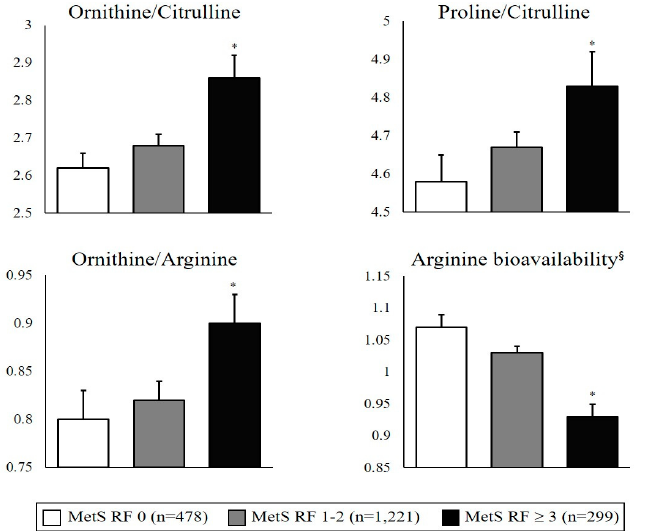
Figure 2. Association between circulating amino acids metabolites and MetS risk status. Data are presented as mean ± standard error; tested after log-transformed; tested by general linear model (GLM) with Bonferroni’s multiple comparisons test (adjustment for age, sex, BMI, cigarette smoking and alcohol consumption); MetS RF: MetS risk factor. * represents significant differences in the values between Mets RF ≥ 3 group and MetS RF 0/MetS RF 1–2 groups; § Arginine bioavailability is defined as Arginine/(Ornithine +